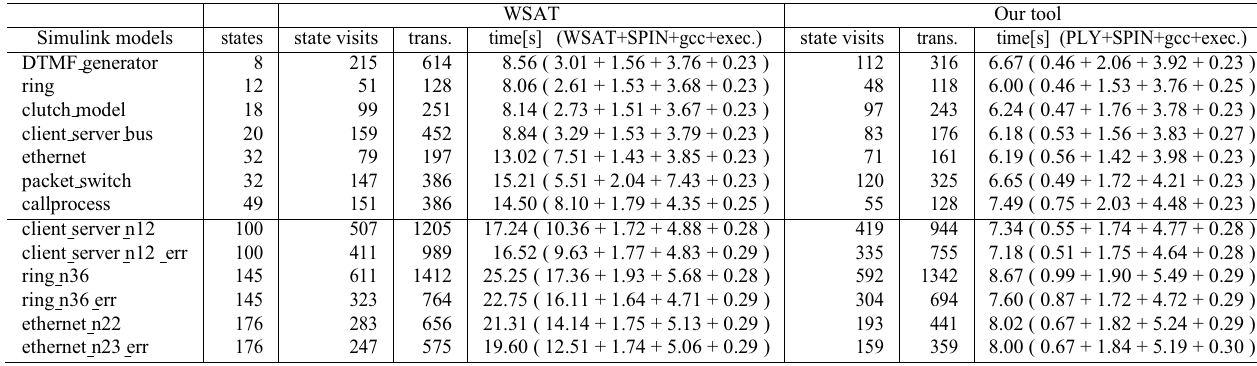
Table 3: Experimental results for checking reachability (nondeterministic) WSAT Our tool Simulink